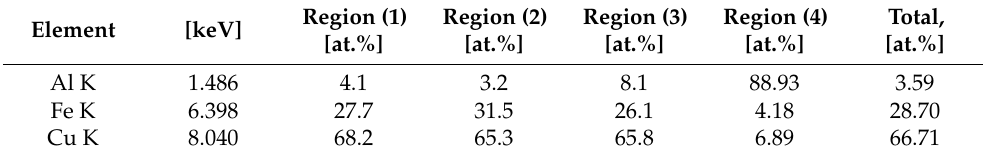
Figure 10. Points visible on the Fast Fourier Transform (FFT) of the image (inset)